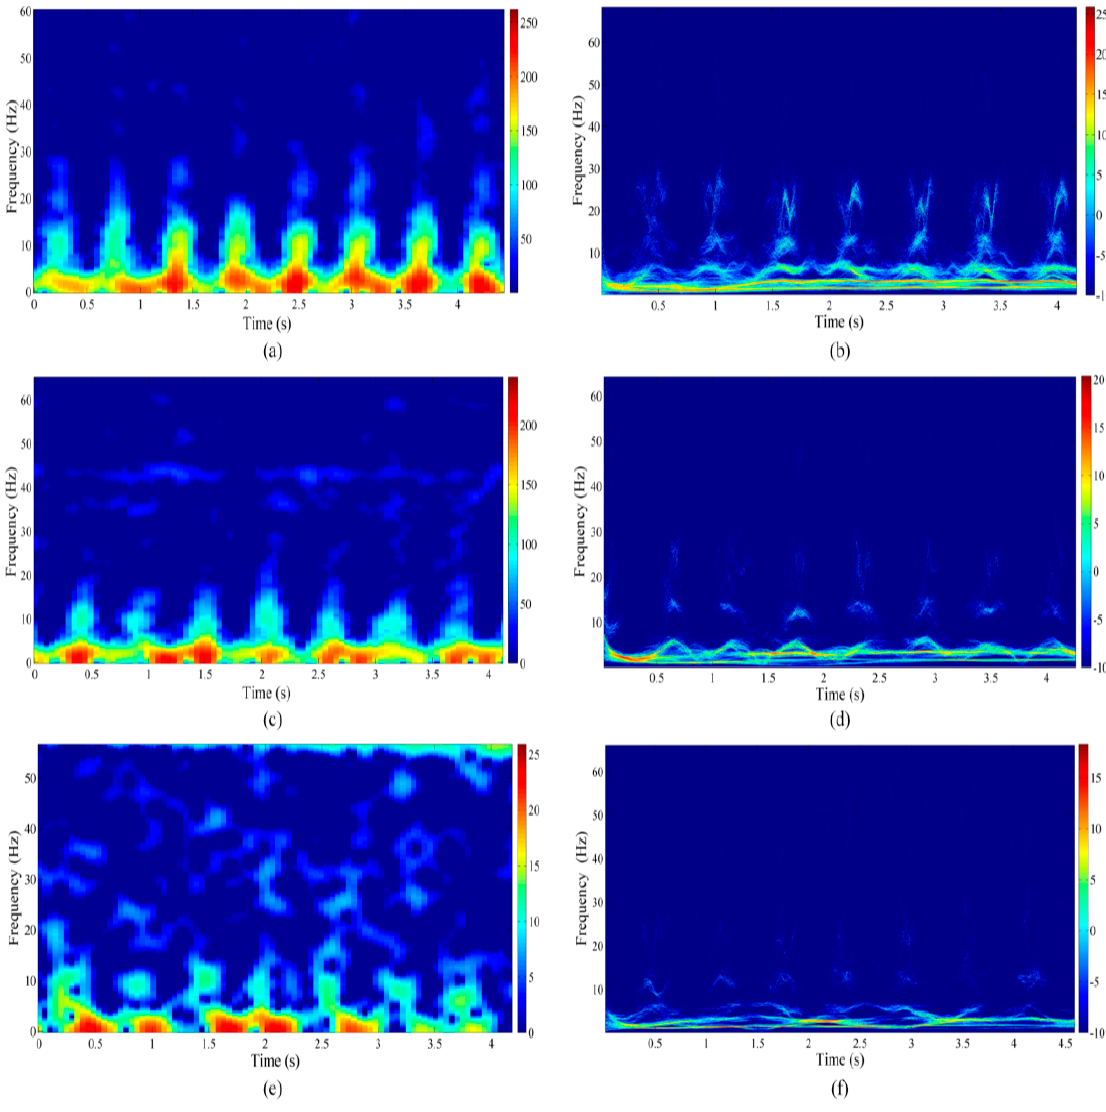
Figure 8. Spectra based on two methods for a subject performing a piaffe while staying in place at different distances behind the wall: ( a ) 4 m, STFT-based spectrum; ( b ) 4 m, MHHT-based spectrum; ( c ) 5 m, STFT-based spectrum; ( d ) 5 m, MHHT-based spectrum; ( e ) 6 m, STFT-based spectrum; and ( f ) 6 m, MHHT-based spectrum.